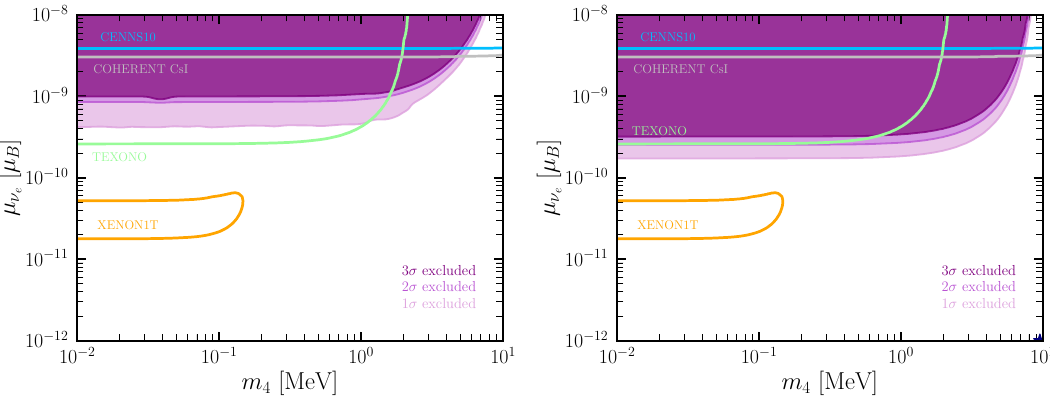
Figure 5 . Results of the analysis for the sterile neutrino dipole portal based on two QF hypotheses: modified Lindhard QF (left graph) and iron-filter QF (right graph). For the former case results follow after marginalization over q and k . Shaded areas indicate the excluded regions at different statistical significance levels: 1 σ , 2 σ and 3 σ as shown in the graphs. Constraints from